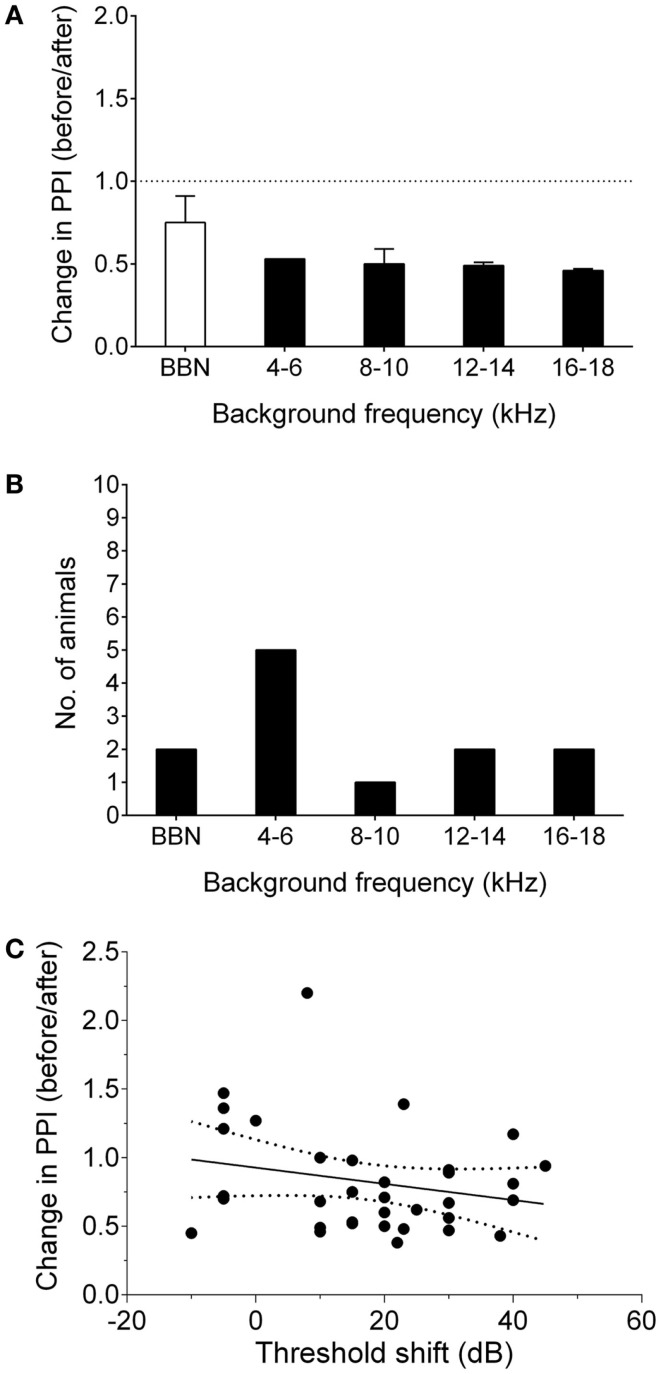
Behavioral signs of tinnitus. (A) Behavioral performance after AOE is shown for a representative “tinnitus” animal, expressed as change in PPI, i.e., a ratio of performance before vs. after noise exposure, at each background frequency. Values <1 indicate poorer gap detection, while a value close to 1 indicates no effect of noise exposure. Black bars indicate frequencies with significantly worse gap detection (P < 0.05). (B) The number of animals exhibiting gap detection deficits at each background frequency. Note: some animals exhibited gap detection deficits at more than one frequency. (C) There was no significant correlation between behavioral performance and ABR threshold shifts. Solid line indicated linear regression. Dotted lines show 95% confidence intervals. Each point represents the behavioral performance for a given background condition in a single animal, relative to the ABR threshold shift at the corresponding frequency.